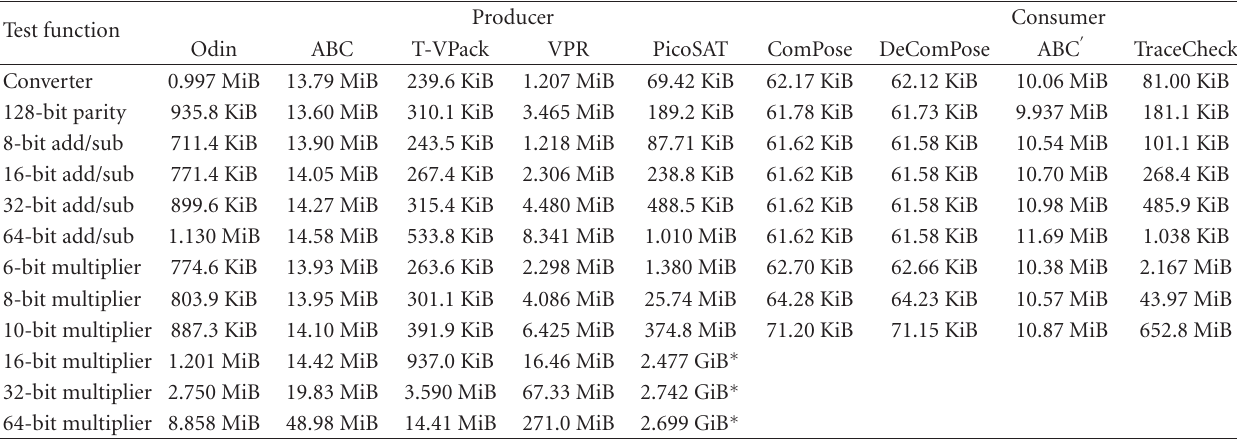
Table 5: Memory usage measurements for producer and consumer in the online CEC scenario. Test function